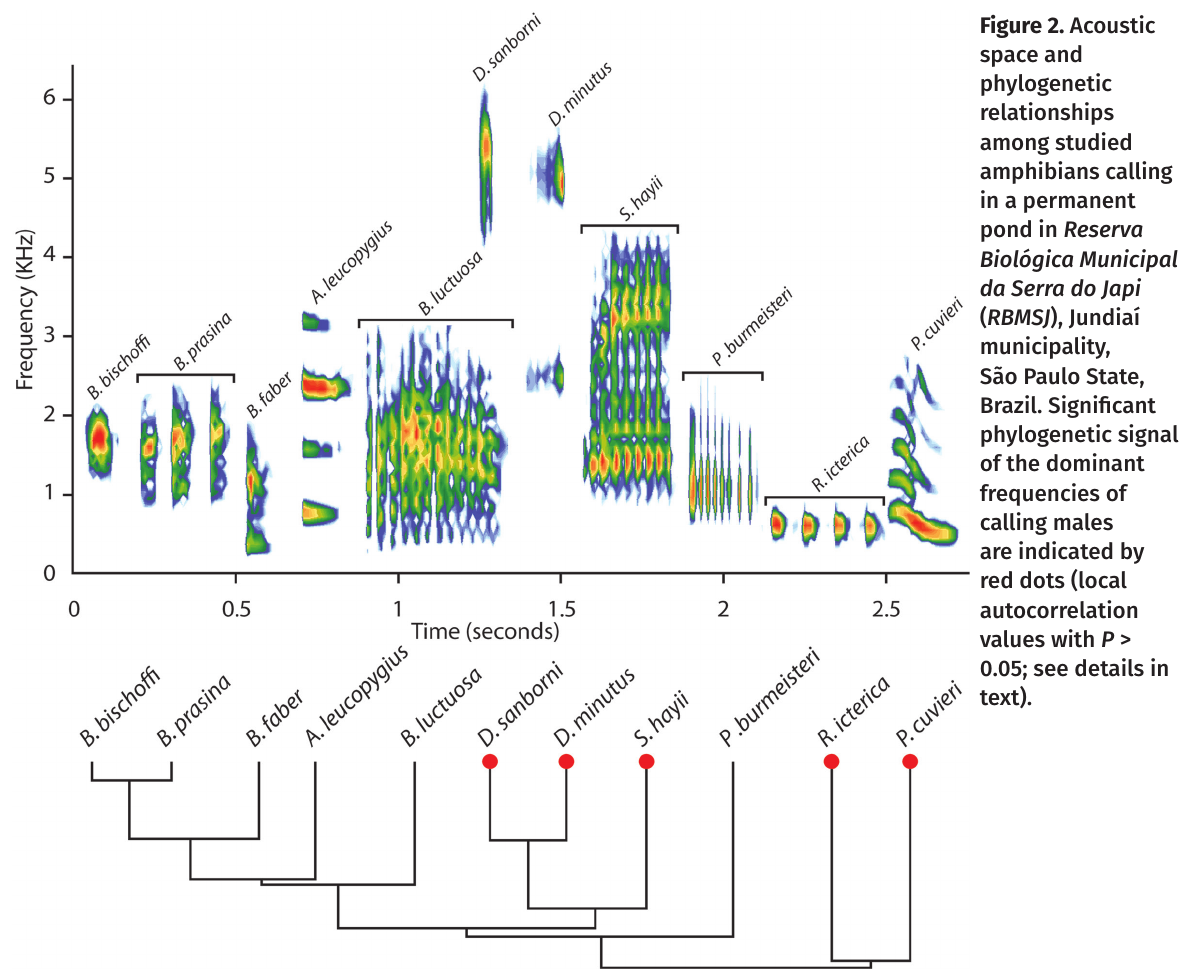
Figure 2. Acoustic space and phylogenetic